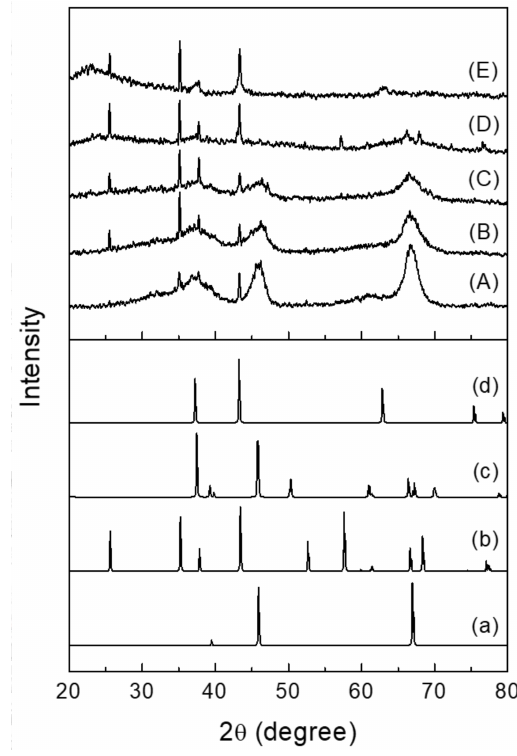
Figure 1. XRD patterns of (A) NiOx / SA-001, (B) NiOx / SA-007, (C) NiOx / SA-028, (D) NiOx / SA-047, and (E) NiOx / SA-386. Inorganic Crystal Structure Database (ICSD) reference patterns of (a) Al 2 O 3 (#30267, Fm3m), (b) Al 2 O 3 (#30025,R3CH), (c) NiO 2 (#88720, C12 / m1), and (d) NiO (#24018,